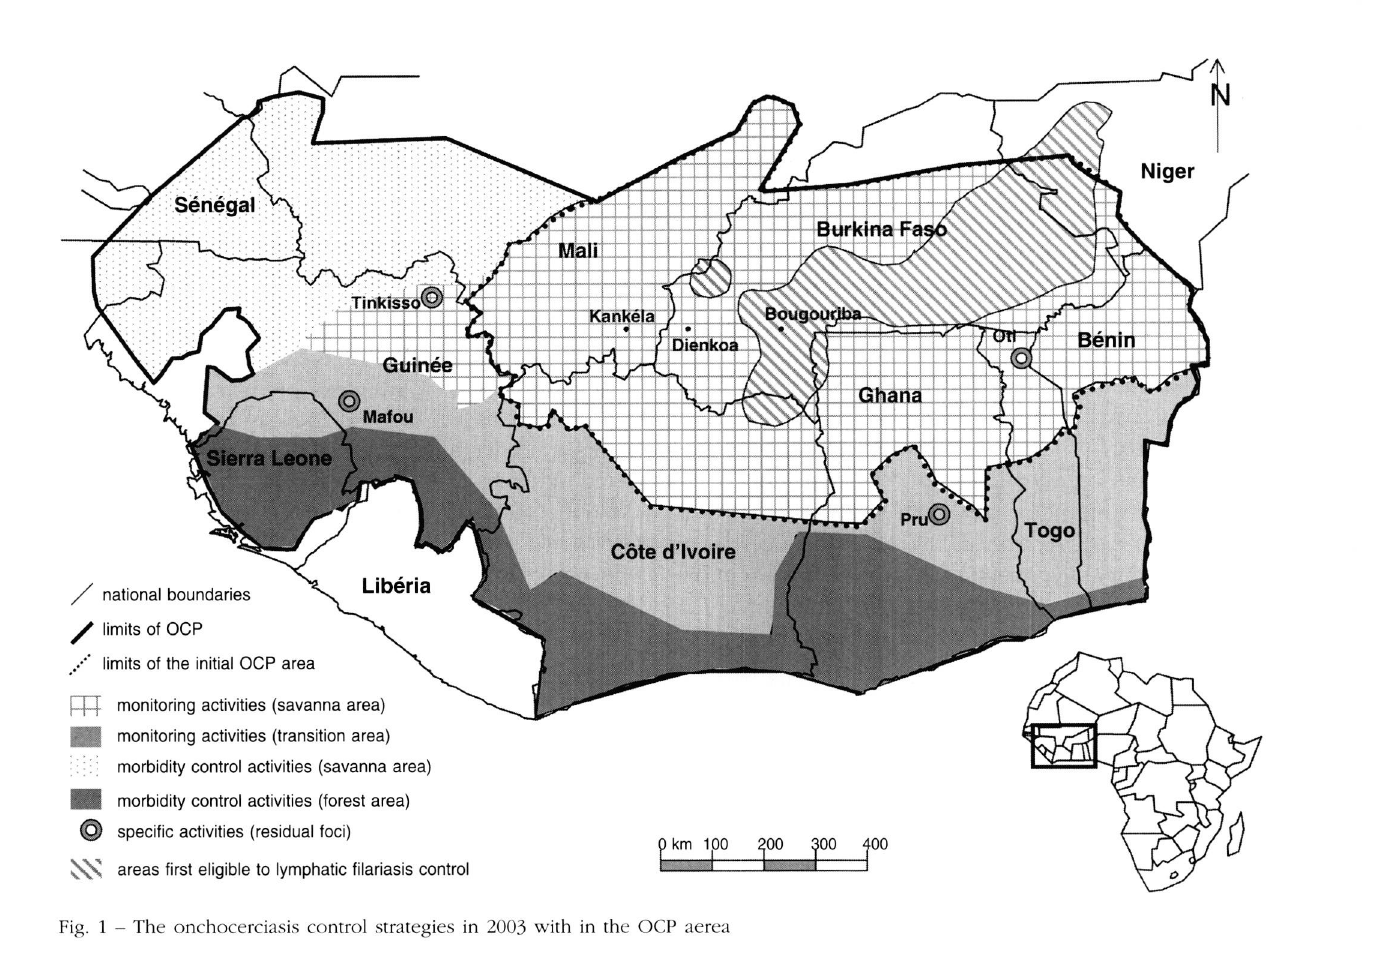
Fig. 1 - The onchocerciasis control strategies in 2003 with in the OCP aerea epidemiological situation is satisfactory in spite of